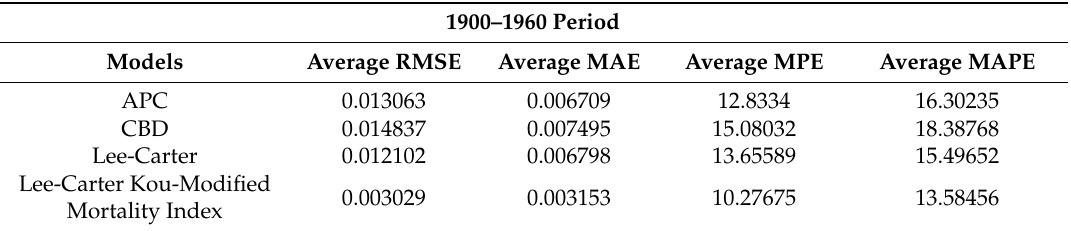
Table 1. Comparison of accuracy measures for the four models under consideration for the 1900–1960 period.